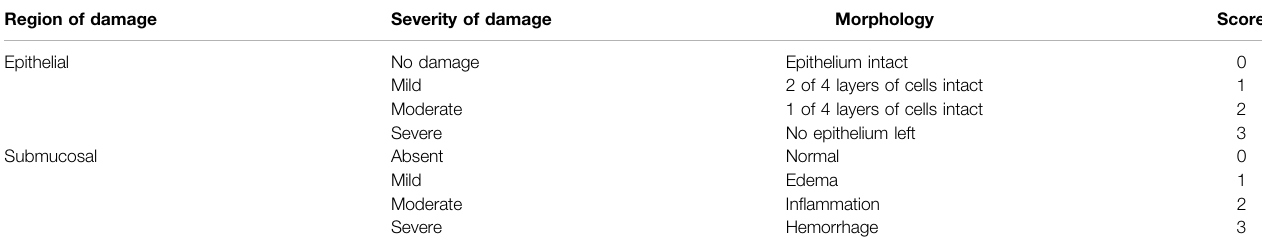
TABLE 1 | Microscopic scoring method (adapted from Reali-Forster et al., 1996; Erben et al., 2014). Region of damage